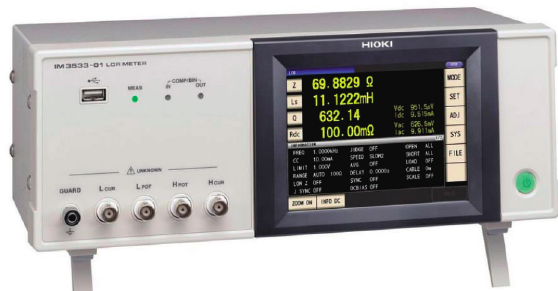
Figure 3: LCR digital bridge (IM3533-01).